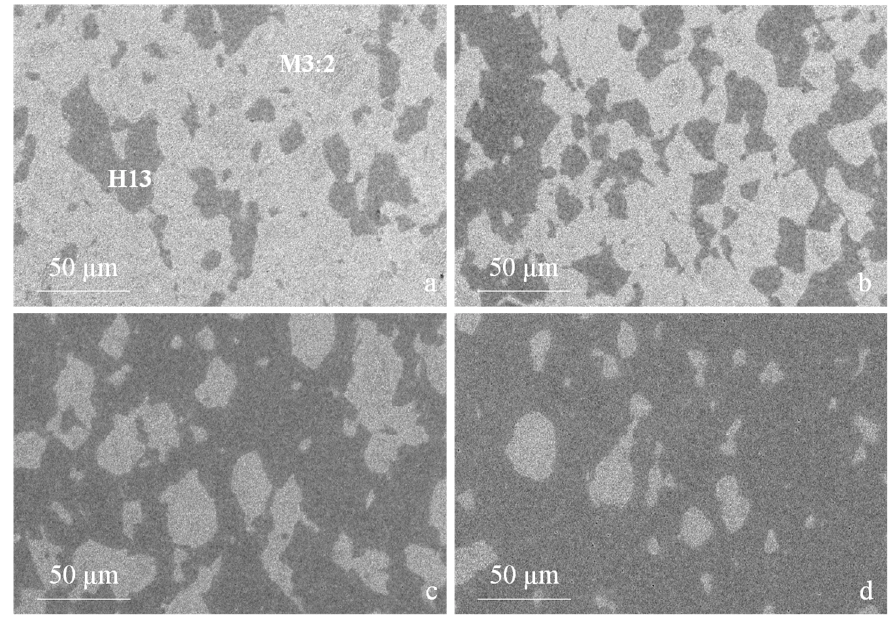
Figure 7. Microstructure of hybrid tool steels (SEM-BSE): MM-20H13 ( a ); MM-40H13 ( b ); MM-60H13 ( c ) and MM-80H13 ( d ). Light and dark regions correspond to M3:2 and H13, respectively.